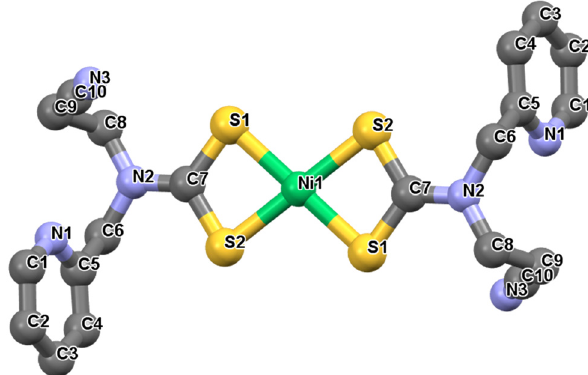
Figure 12: Molecular structure of Ni ( S 2 CN ( 3 -(( pyridin - 2 - yl ) methyl - amino ) propanenitrile ) . Redrawn from ref. [ 50 ] , with permission from Elsevier ( Copyright 2020 ) .